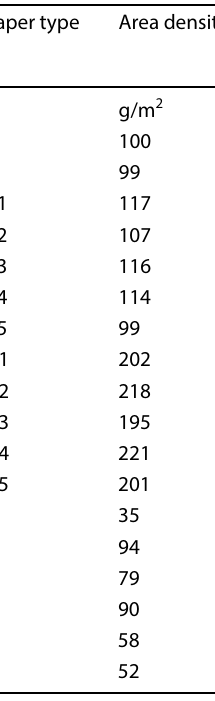
Table 2 Summary of results of tensile tests